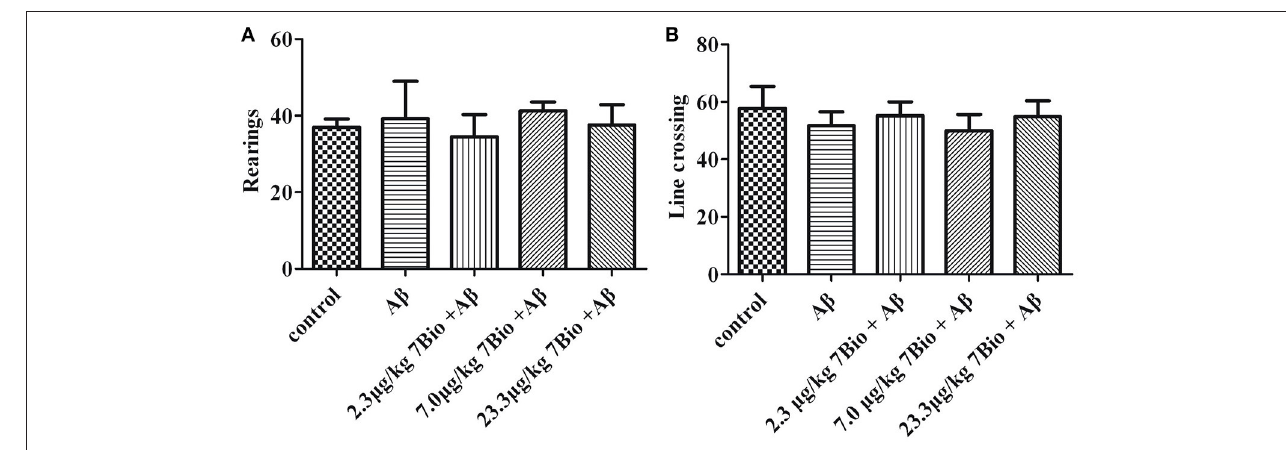
Frontiers in Molecular Neuroscience |